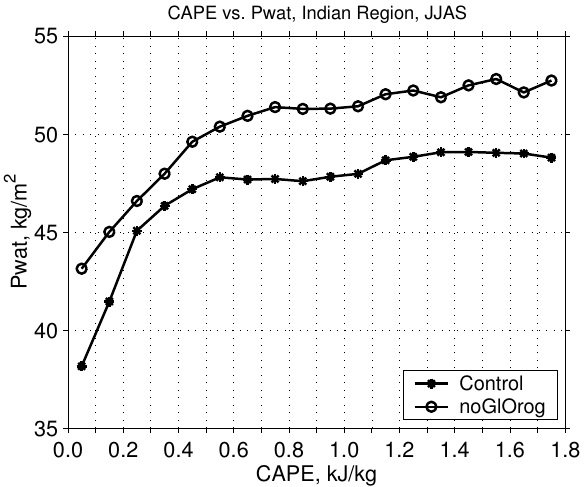
Fig. 8. Relation between convective available potential energy (CAPE) and total column precipitable water (P wat ) over the Indian region from the control and noGlOrog simulations. Note that for CAPE values below 0.4kJkg − 1 the rate of increase of P wat with CAPE is higher in the control as compared to the noGlOrog . This is unlike the SMSE-CAPE relationship shown in Fig. 3. Thus, the relationship between CAPE and P wat does depend on the presence of orography.